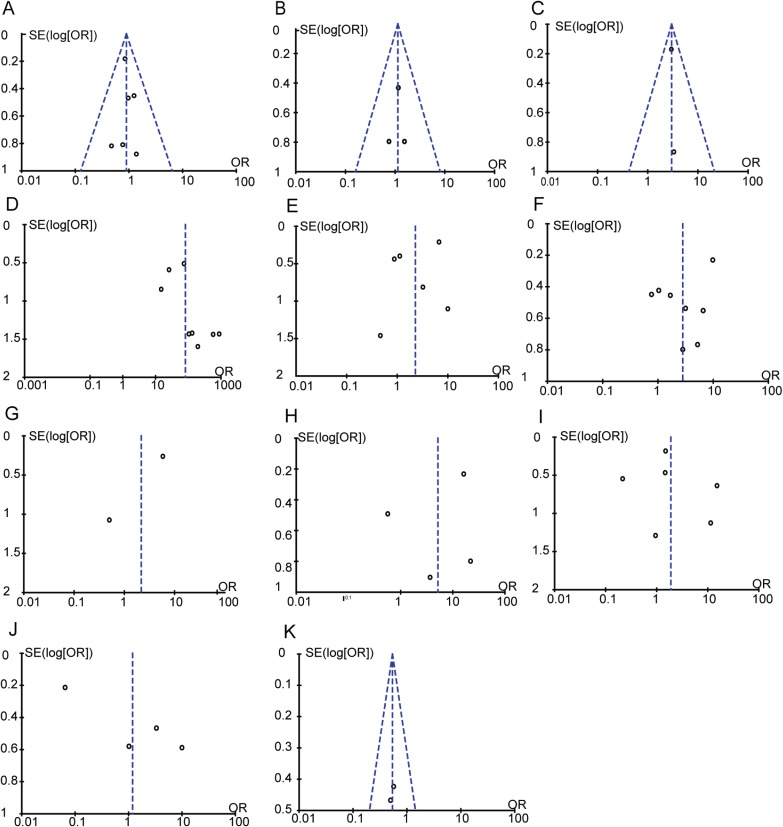
Funnel plot.(A) Overexpression of EpCAM in male group and female group. (B) Overexpression of EpCAM in age > 60 group and age ≤60 group. (C) Overexpression of EpCAM in tumour >5 cm group and tumour ≤5 cm group. (D) Overexpression of EpCAM in gastric cancer group and control group. (E) Overexpression of EpCAM in T3~T4 group and T1~T2 group. (F) Overexpression of EpCAM in LN (+) and LN (–) gastric cancer group. (G) Overexpression of EpCAM in D (+) and D (–) gastric cancer group. (H) Overexpression of EpCAM in Ⅲ~Ⅳ group and Ⅰ~Ⅱ group. (I) Overexpression of EpCAM in poorly differentiated group and well/moderate differentiated group. (J) Overexpression of EpCAM in intestinal group and diffuse group. (K) 5-year overall survival between EpCAM (+) and EpCAM (–) groups.